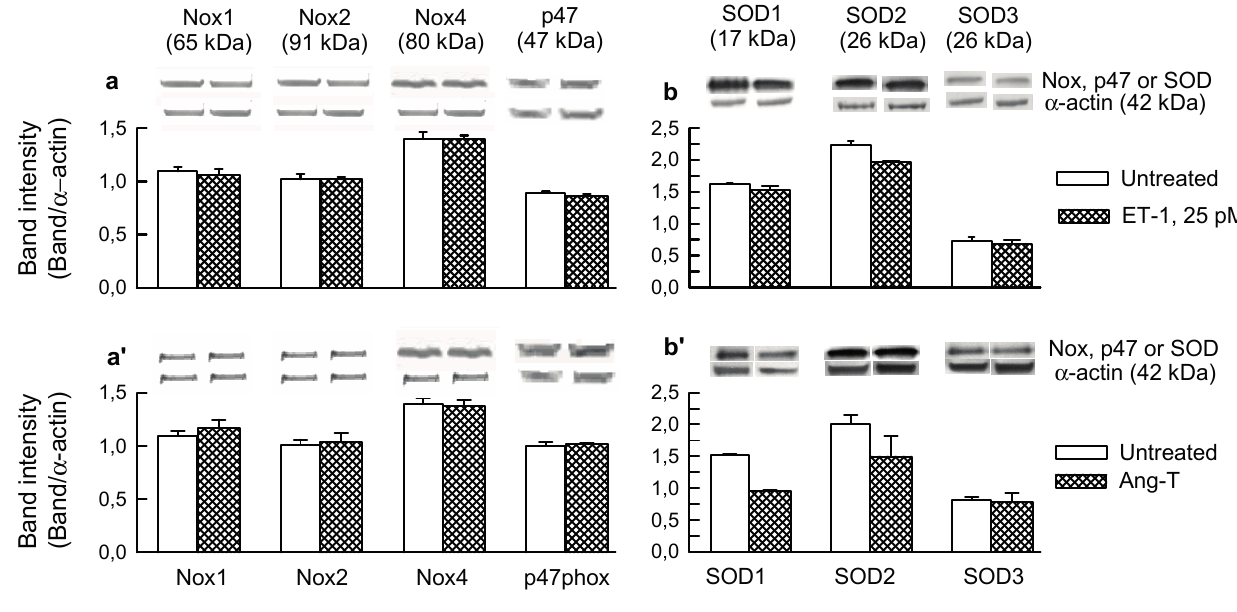
Figure 5. Expression of Nox1, Nox2, Nox4, and p47phox proteins ( a , a' ); and of SOD1, SOD2, and SOD3 proteins ( b , b' ) in control guinea-pig hearts and in hearts perfused for 10 min with: ( a , b ) endothelin-1 (ET-1, 25 pM) and ( a' , b' ) 20 nM angiotensin combined with 5 nM tezosentan (Ang-T). In each section, top panel depicts original Western blot of a given protein and of α -actin. The plots below represent the band intensities evaluated using densitometry and normalised against α -actin and are the mean ± SEM of four